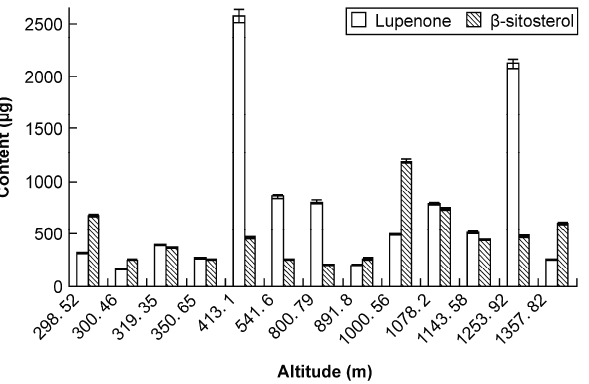
Figure 4. Lupenone and β -sitosterol levels in Rhizoma Musae samples from different altitudes and origins.